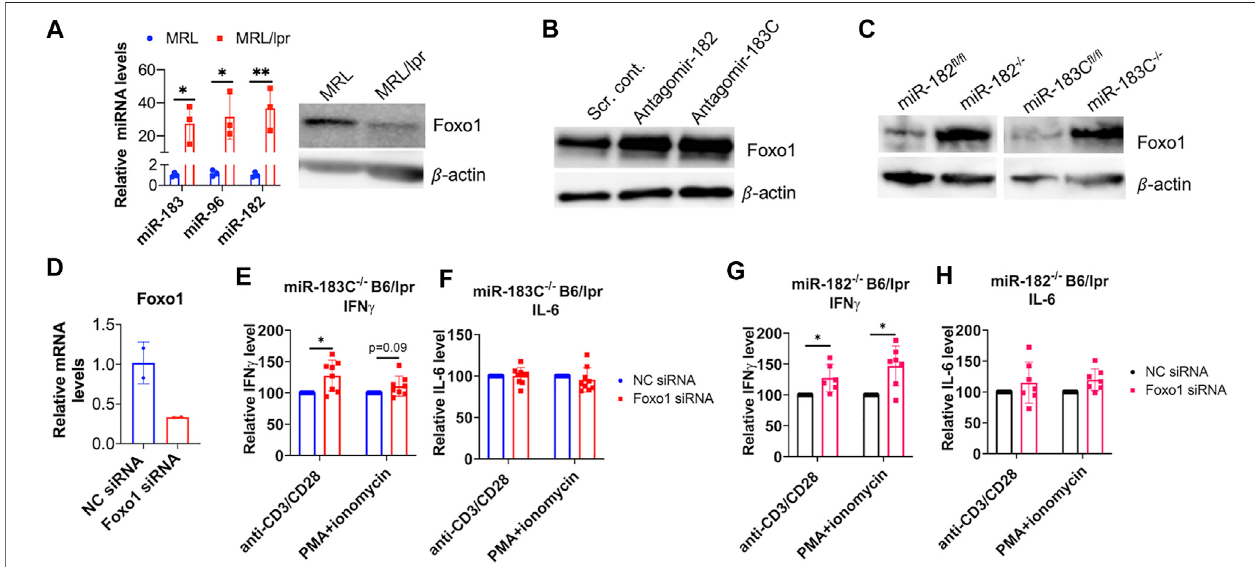
FIGURE 7 | miR-183C and miR-182 miRNAs regulate IFN γ production via targeting Foxo1. (A) An inverse relationship between miR-183 miRNAs expression of Foxo1 protein expression in control MRL and autoimmune-prone MRL/lpr mice splenocytes. The left graph showed relative miR-183, -96, -182 miRNAs expression in thesplenocytesofMRLandMRL/lpr mice(14 – 15 weeksofage).Thegraphshowedmeans±SD( n =3each).Unpairedstudentt-test(MRLvs.MRL/lpr);*, p < 0.05;**, p < 0.01. The right panel showed western blotting of Foxo1 and β -actin (loading control) protein expression in MRL and MRL/lpr splenocytes. The representative western blotting image from three independent experiment was shown. (B) Increased Foxo1 protein in antagomir-182 or antagomir-183C treated splenocytes from MRL/lprmice.Therepresentativewesternblottingimagefromtwoindependentexperimentswasshown. (C) IncreasedFoxo1proteinexpressioninsplenicCD4 + Tcells frommiR-183C − / − B6/lpr(miR-183C − / − ),miR-182 − / − B6/lpr(miR-182 − / − )micewhencomparedtothecellsfromtheirrespectivecontrolmiR-183C fl / fl B6/lpr(miR-183C fl / fl ) andmiR-182 fl / fl B6/lpr(miR-182 fl / fl )mice.Therepresentativewesternblottingimagefromatleastthreeindependentexperimentswasshown. (D) ReducedFoxo1mRNA expressioninFoxo1siRNAtreatedcellswhencomparedtonegativecontrolsiRNA(NCsiRNA)treatedcells.Thegraphshowedmeans±SD( n =2each). (E – H) Inhibition of Foxo1 in vitro in splenocytes of miR-183 − / − (E,F) and miR-182 − / − (G,H) mice increased IFN γ , but not IL-6 production in response to anti-CD3/anti-CD28 or PMA/ ionomycin stimulation. The cytokine level in Foxo1 siRNA treated samples were shown as the percentage of paired NC siRNA treated cells. The graphs were shown as means ± SD ( n ≥ 4). Paired student t tests were performed (NC siRNA vs. Foxo1 siRNA); *, p < 0.05 and **, p < 0.01.